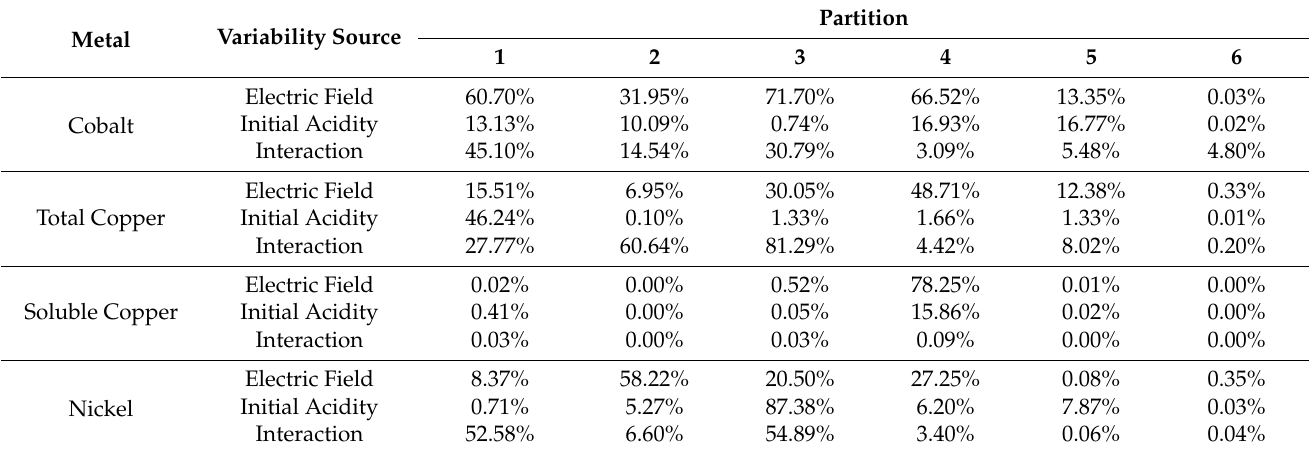
Table 4. Calculated p -values of each factor and their interaction for each